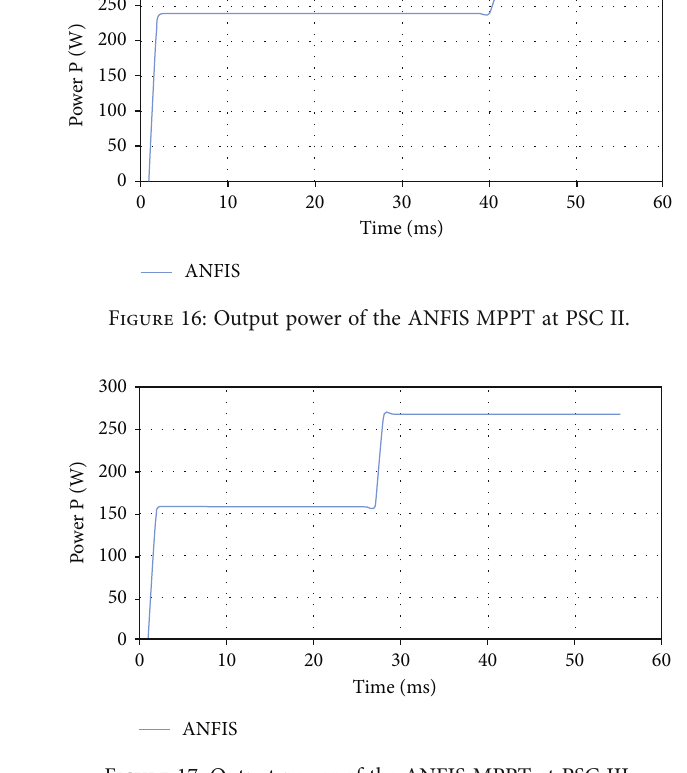
Figure 17: Output power of the ANFIS MPPT at PSC III. Table 1: Output